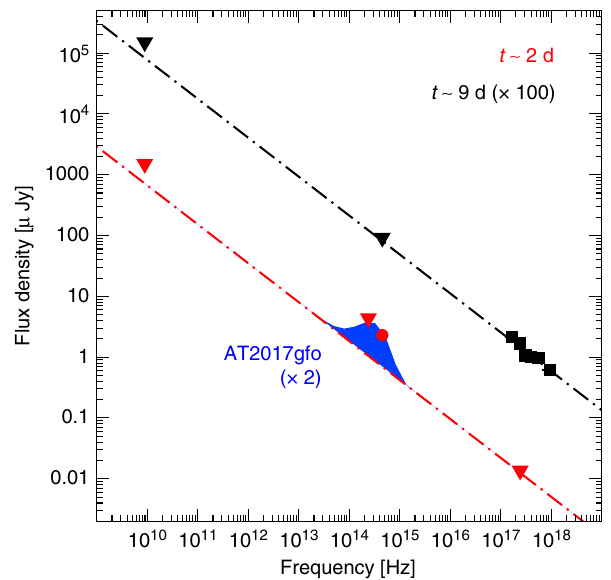
Fig. 4 Spectral energy distribution of GRB150101B. Downward triangles are 3 σ upper limits. At early times, the optical light is brighter than expected based on the extrapolation of the X-ray constraints (dot-dashed line), suggesting that it belongs to a different component of emission. The blue area shows the spectrum of AT2017gfo 8,10,20 at 1.5 days, rescaled by a factor 2 in order to match the optical brightness of GRB150101B. At later times, the lack of optical detection is consistent with the X-ray afterglow behavior. At both epochs, our model is consistent with the lack of radio detection at 5.7 d At later times, this excess is no longer visible. The deep upper limit from Gemini shows that at ~10 days the afterglow became the dominant component and the kilonova already faded away. This is consistent with the behavior of AT2017gfo 8,10,20 , and predicted in general by kilonova models 13,29,30 .